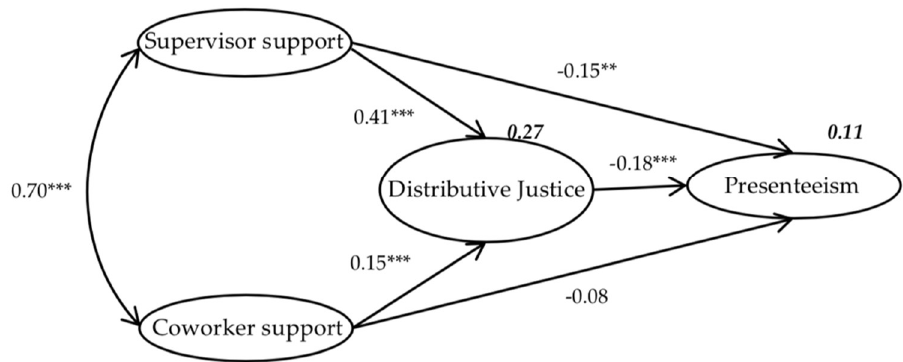
Figure 1. Final structural equation model, with standardized maximum likelihood estimates (numbers not in bold are standardized regression coefficients, and numbers in bold represent variability; Chi-square, 852.853, degree of freedom, 98.033, p < 0.001; root mean square error of approximation was 0.071, goodness-of-fit index was 0.934, comparative fit index was 0.949, Tucker–Lewis index was 0.937 and normed fit index was 0.934; ** significant at 0.001 < p < 0.01; *** significant at p < 0.001.).